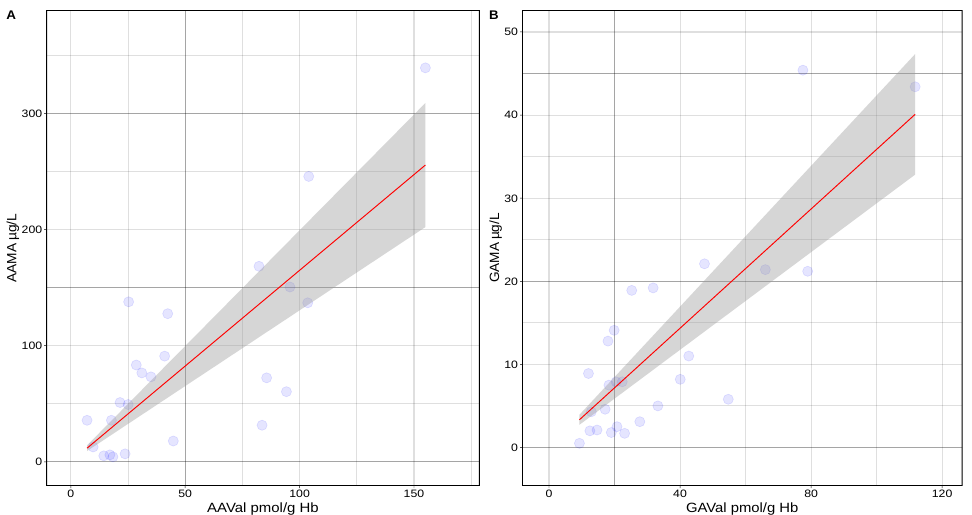
Figure 3. Linear model of corresponding acrylamide biomarkers in blood and urine matrix. Regres- sion of AAMA vs. AAVal (( A ), AAMA (µg/L) = 1.64 × AAVal, pmol/g Hb, p < 0.0001) and GAMA and GAVal (( B ), GAMA (µg/L) = 0.35 × GaVal, pmol/g Hb, p < 0.0001) in individuals (data kindly provided by T. Schettgen, M.B. Boettcher, J. Angerer). Red = regression line, blue = data points, grey = 95% confidence